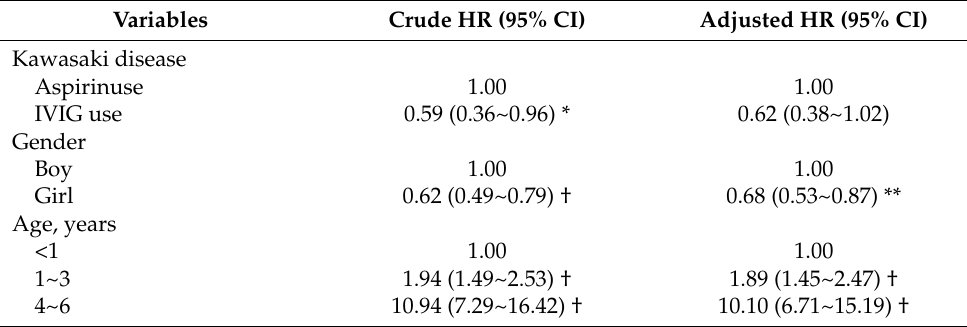
Table 2. Comparison the incidence of myopia between aspirin and IVIG